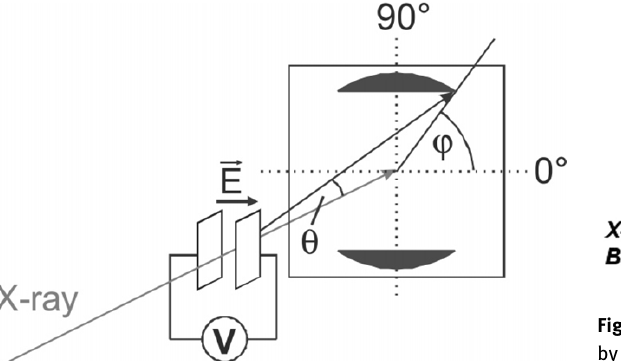
Figure 15: Experimental setup for In situ SAXS [96]